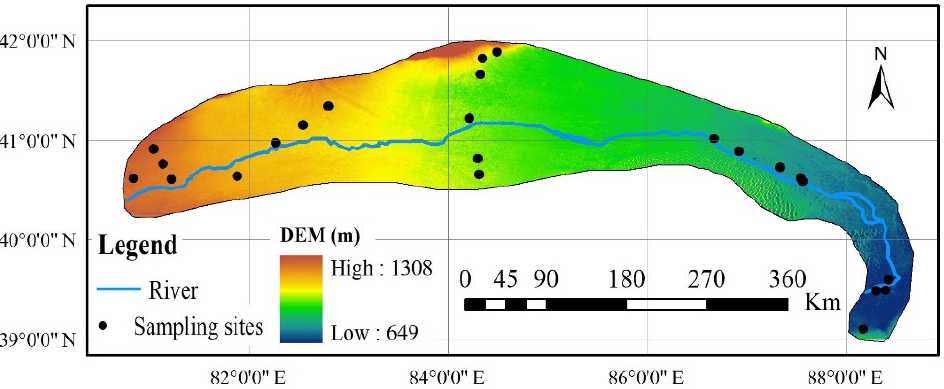
Figure 1. The sampling sites in the Tarim River Basin.